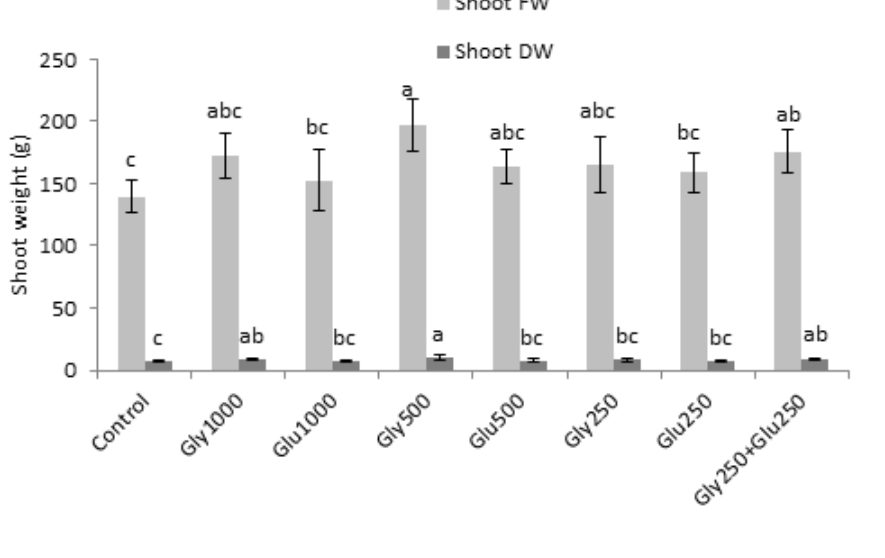
Figure 1: Shoot fresh and dry weight of lettuce plants under foliar application of glycine and glutamine amino acids. Data are average of four replications ± SD; comparison of means was done at 5% level of Duncan multiple ranges